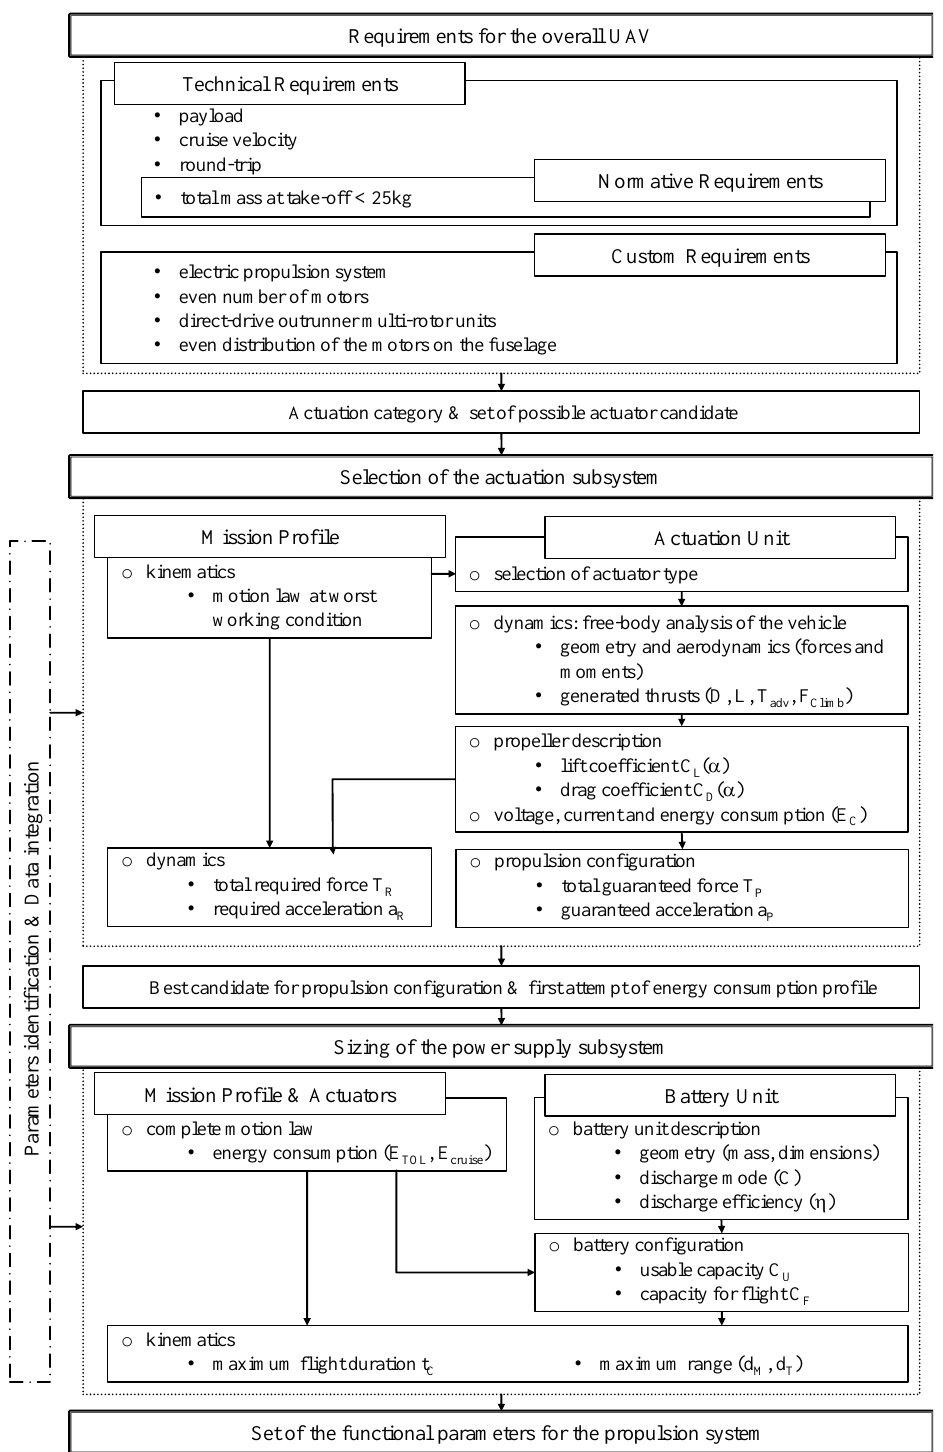
Figure 4. Synthetic road-map of the integrated functional design framework for the propulsion system